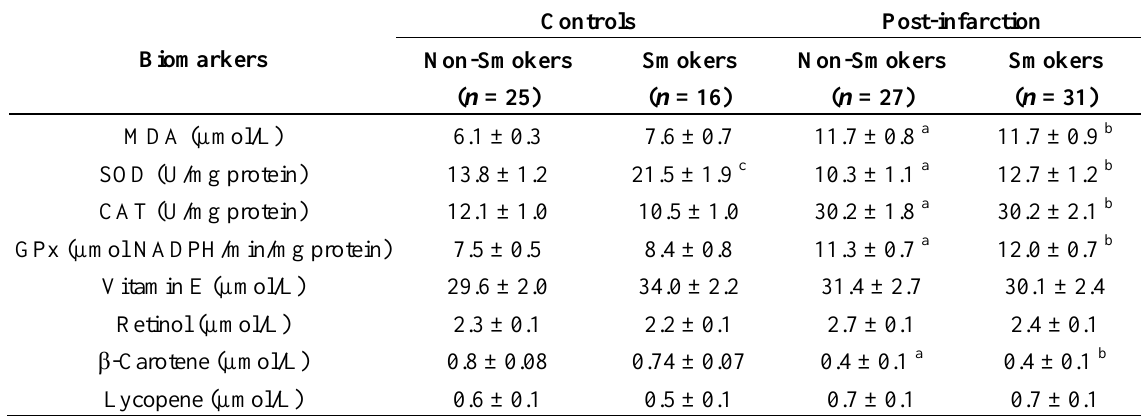
Table 3. Biomarkers of oxidative stress obtained from controls and subjects after an acute myocardial